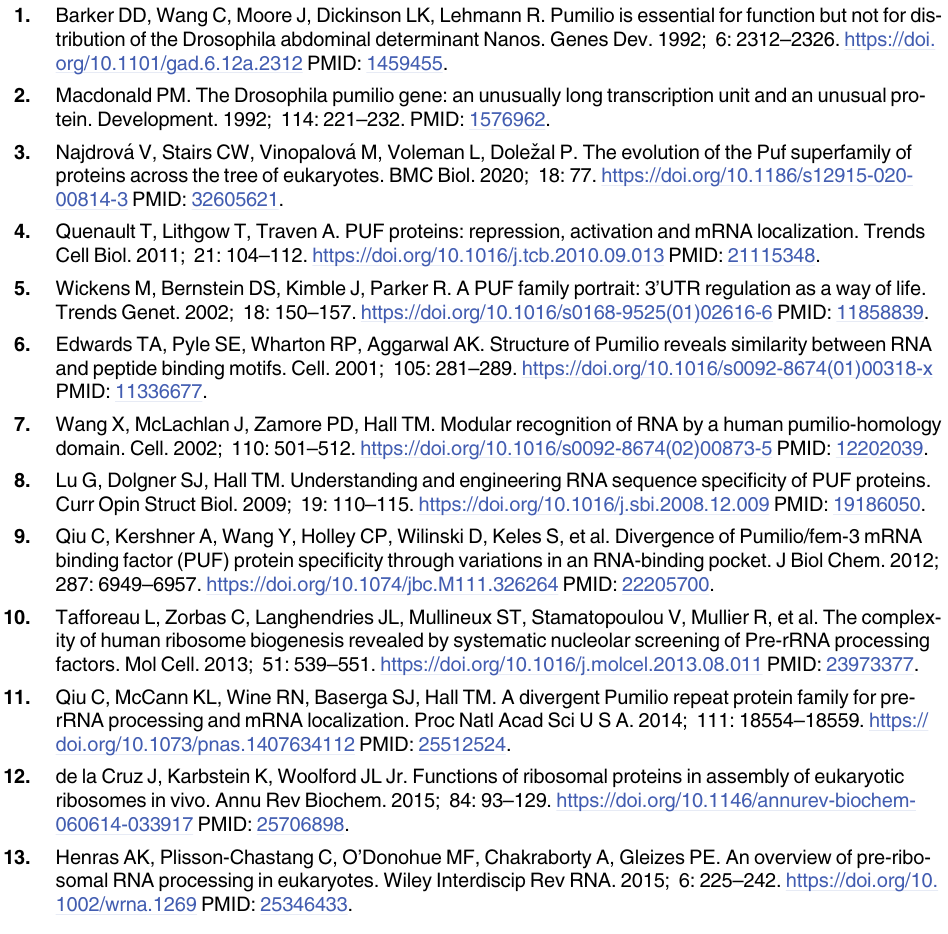
S4 Fig. Uncropped images for all gels and Western